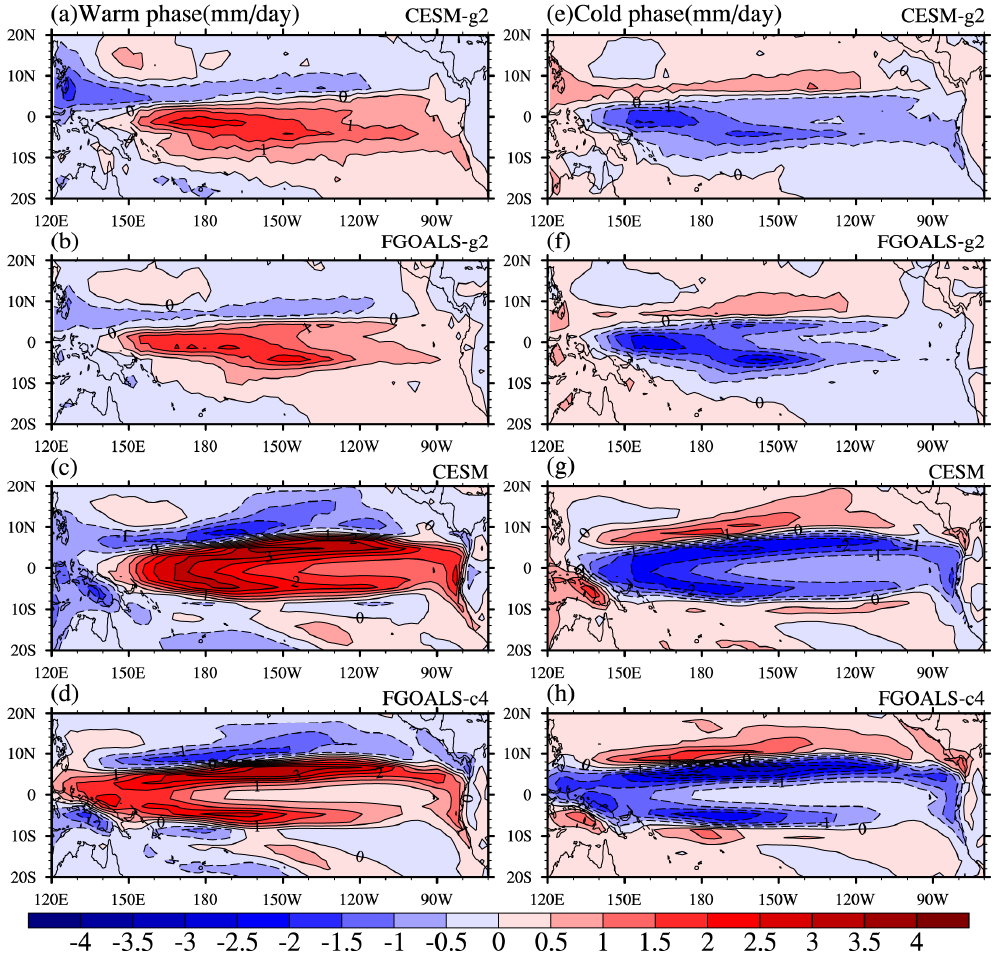
Figure 5. Spatial patterns of averaged composite anomalies of the warm phase (Left) and cold phase (Right) for convective precipitation from the four cross-coupled parent models: ( a , e ) CESM-g2, ( b , f ) FGOALS-g2, ( c , g ) CESM, ( d , h ) FGOALS-c4.